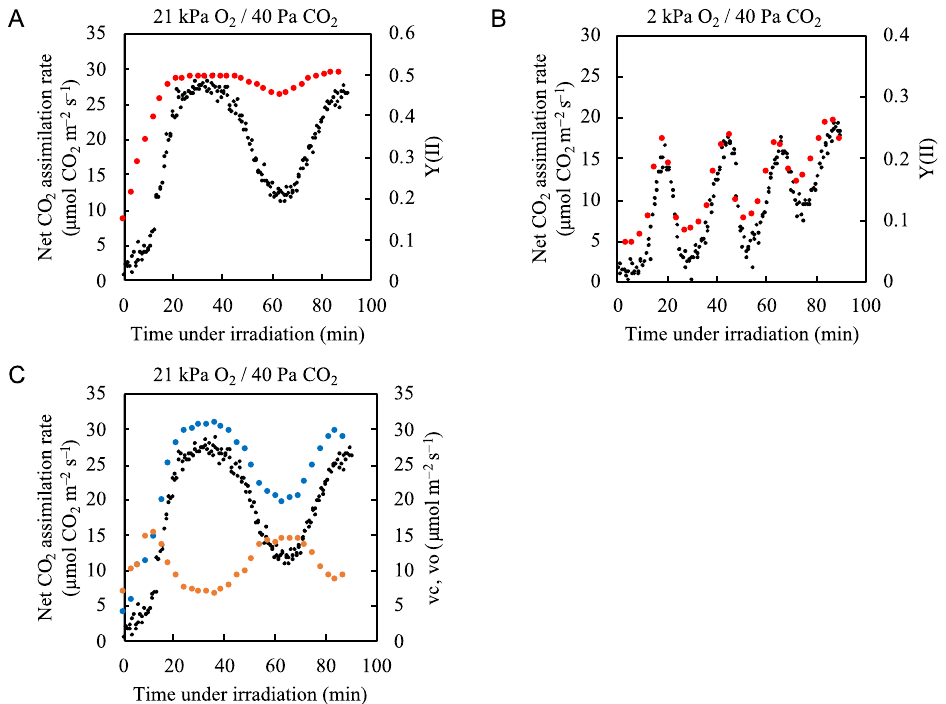
Figure 2. Effects of partial pressure of O 2 on both the net CO 2 assimilation rate and quantum yield of PSII (Y(II)) in rice leaves. The net CO 2 assimilation rate (black circles) and Y(II) (red circles) were simultaneously measured under ( A ) 21 kPa O 2 /40 Pa CO 2 conditions and ( B ) 2 kPa O 2 /40 Pa CO 2 conditions. Actinic light (700 µmol photons m –2 s –1 ) was turned on at 0 min. The data for the net CO 2 assimilation rate at 21 kPa O 2 /40 Pa CO 2 conditions are the same as those used for Figure 1A. ( C ) Both ribulose 1,5-bisphophate (RuBP) carboxylation rate (vc) (blue circles) and RuBP oxygenation rate (vo) (orange circles) were estimated by the method, described in Materials and Methods. Both vc and vo as well as the net CO 2 assimilation rate (black circles) are plotted against the time after illumination of actinic light.